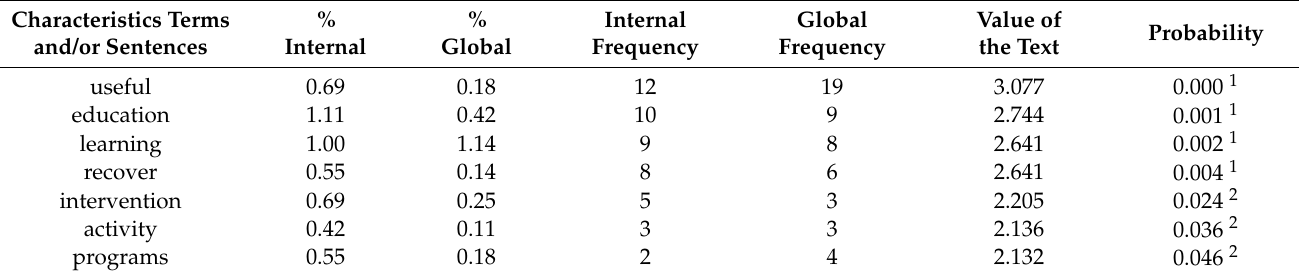
Table 7. Teachers’ answers to the question “How the school could reduce school